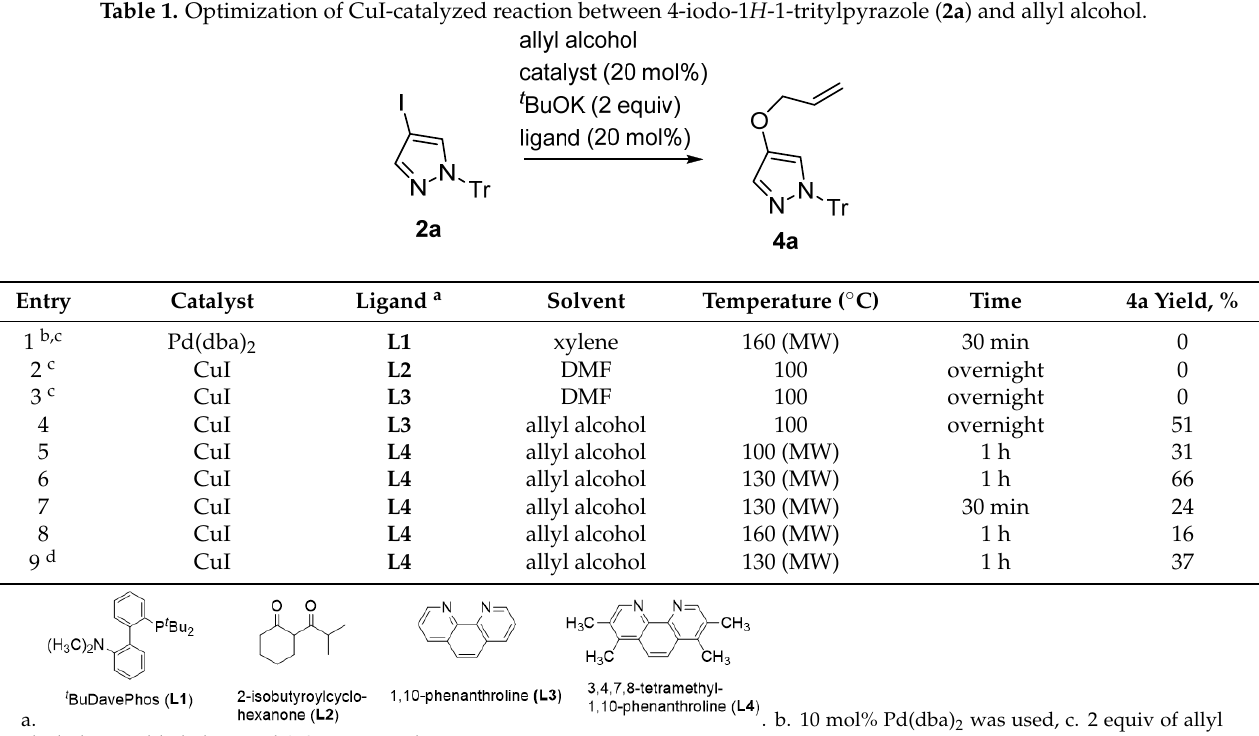
Table 1. Optimization of CuI-catalyzed reaction between 4-iodo-1 H -1-tritylpyrazole ( 2a ) and allyl alcohol.